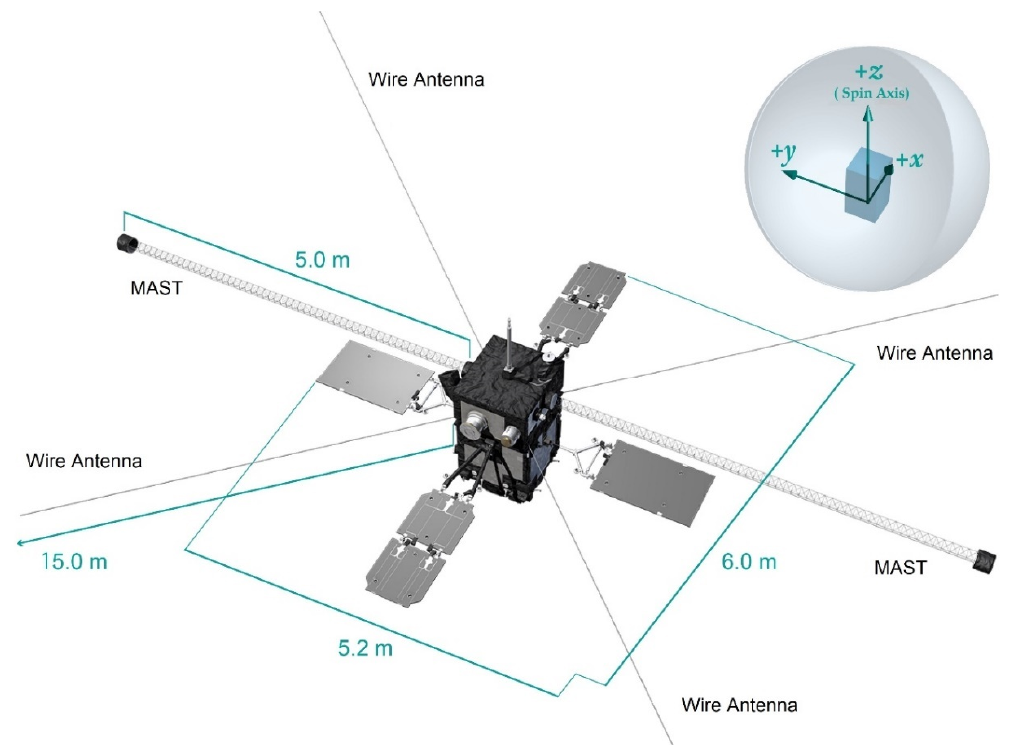
Figure 1. Arase and its configuration in the nominal mission phase (courtesy of ISAS / JAXA).